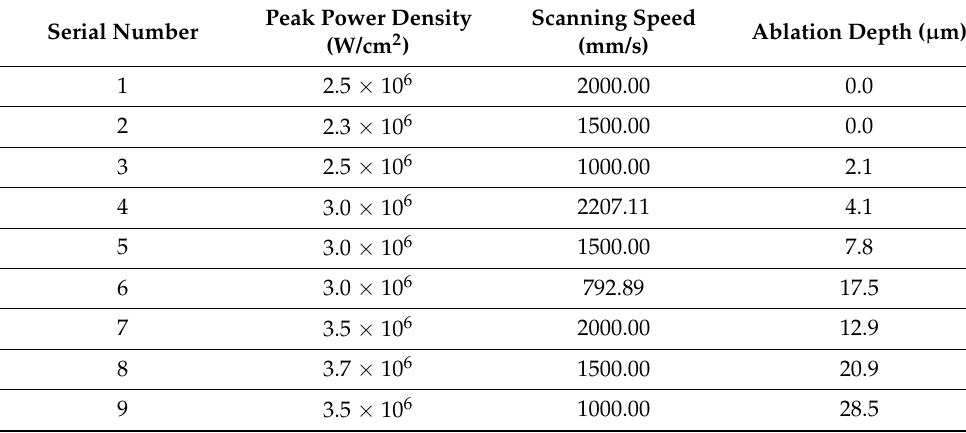
Table 3. Ablation depth of the layered model under various laser